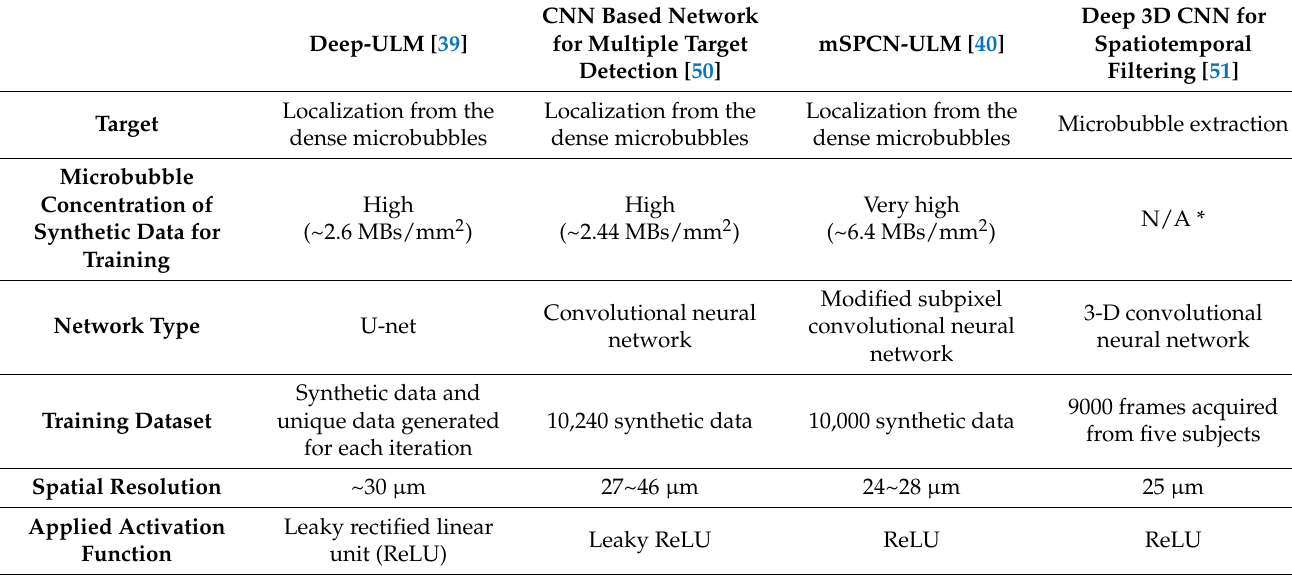
Table 2. An overall comparison of the representative deep learning-based technologies currently used in SRU imaging. * Only in vivo data were used for training. The dosage of injected microbubble is 2.5 × 10 7 MBs in 60 µ L